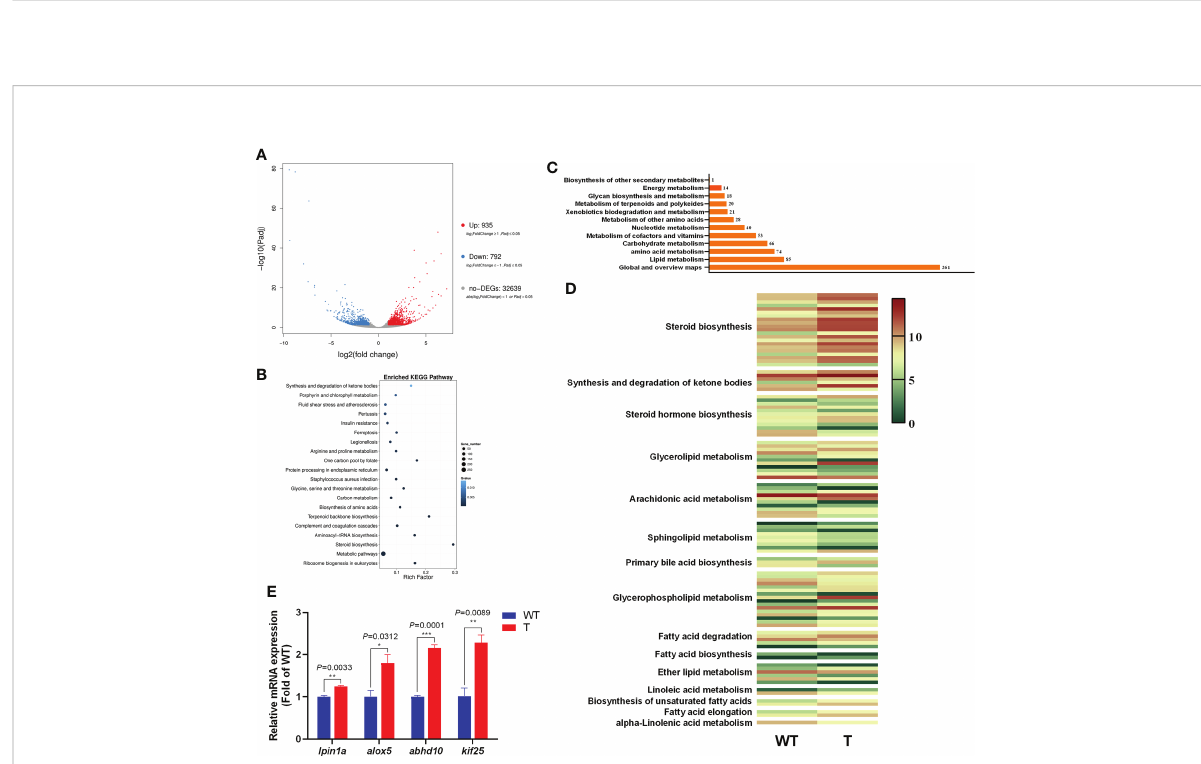
FIGURE 4 Transcriptome analysis of the differentially expressed genes (DEGs) in the liver of wild-type (WT) and GH transgenic (T) common carp. (A) Volcano-plot map of DEGs. (B) Enriched KEGG pathway of the DEGs in the liver of WT and T common carp; the size of the point represents the number of DEGs (the larger the point, the larger the number). (C) Functional classi fi cation of DEGs in metabolic pathways. (D) Heat map of the expression level of genes involved in lipid metabolism; red and green indicate higher and lower expression, respectively. (E) qPCR validation of DEGs. *, ** and *** indicate 0.01<P<0.05, 0.001<P<0.01, 0.0001<P<0.001, respectively, between WT and T common